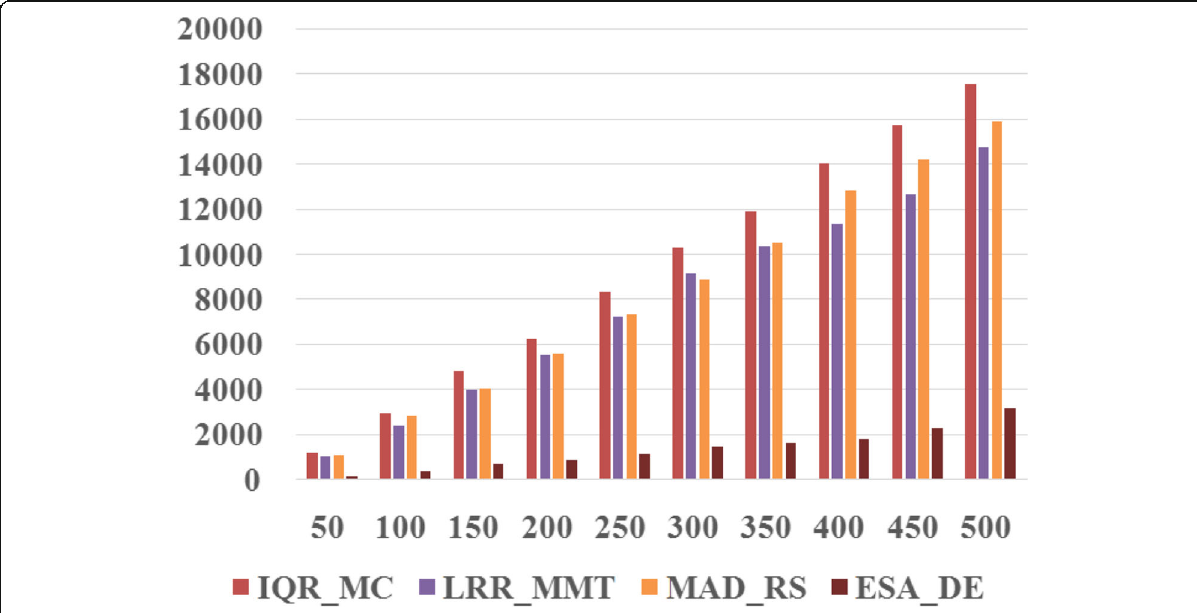
Fig. 8 Total performance interference of virtual machine under different task numbers